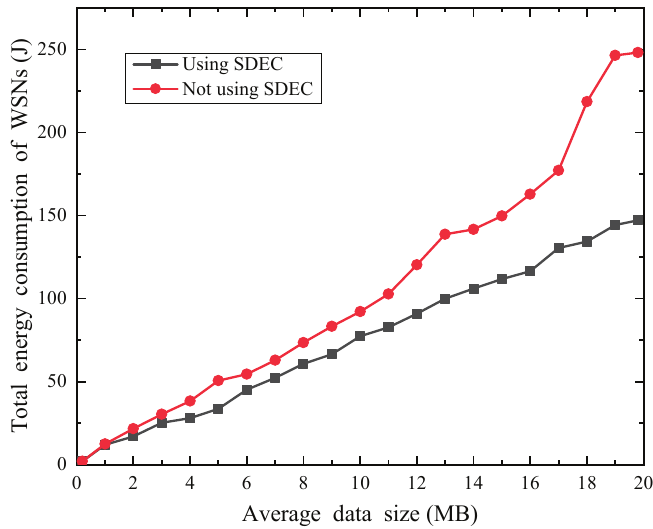
Figure 6. Change diagram of total energy